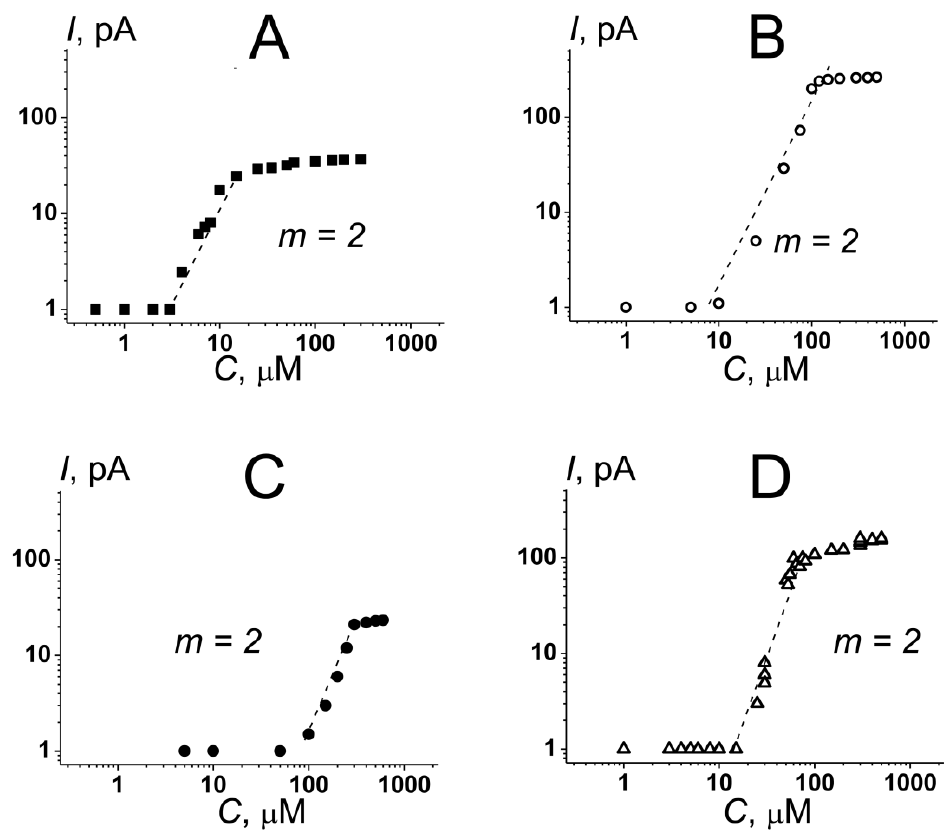
Figure 2. Dependence of the steady-state nisin-induced transmembrane current on the concentration of the lantibiotic in bilogarithmic coordinates. The membranes were made from ( A ) DOPC/DOPG (50/50 mol%), ( B ) DOPC/TOCL (50/50 mol%), ( C ) DOPE/DOPG (50/50 mol%), and ( D ) DOPE/TOCL (50/50 mol%) and bathed in 0.1 M KCl, pH 7.4. V = 100 mV. The slope ( m ) of the linear function fitting the growth region of the dependence characterizes the number of nisin molecules involved in the pore formation in membrane of appropriate composition.